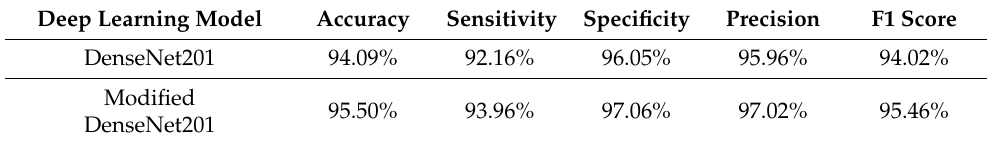
Table 4. Classification results using Modified